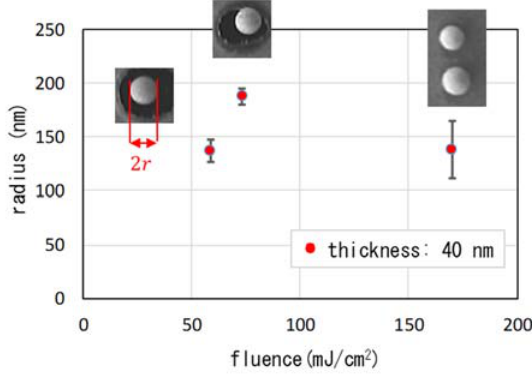
Figure 7. Radius of nanoparticles as a function of fluence. The film thickness was 40 nm. The error bars reflect the s.d.